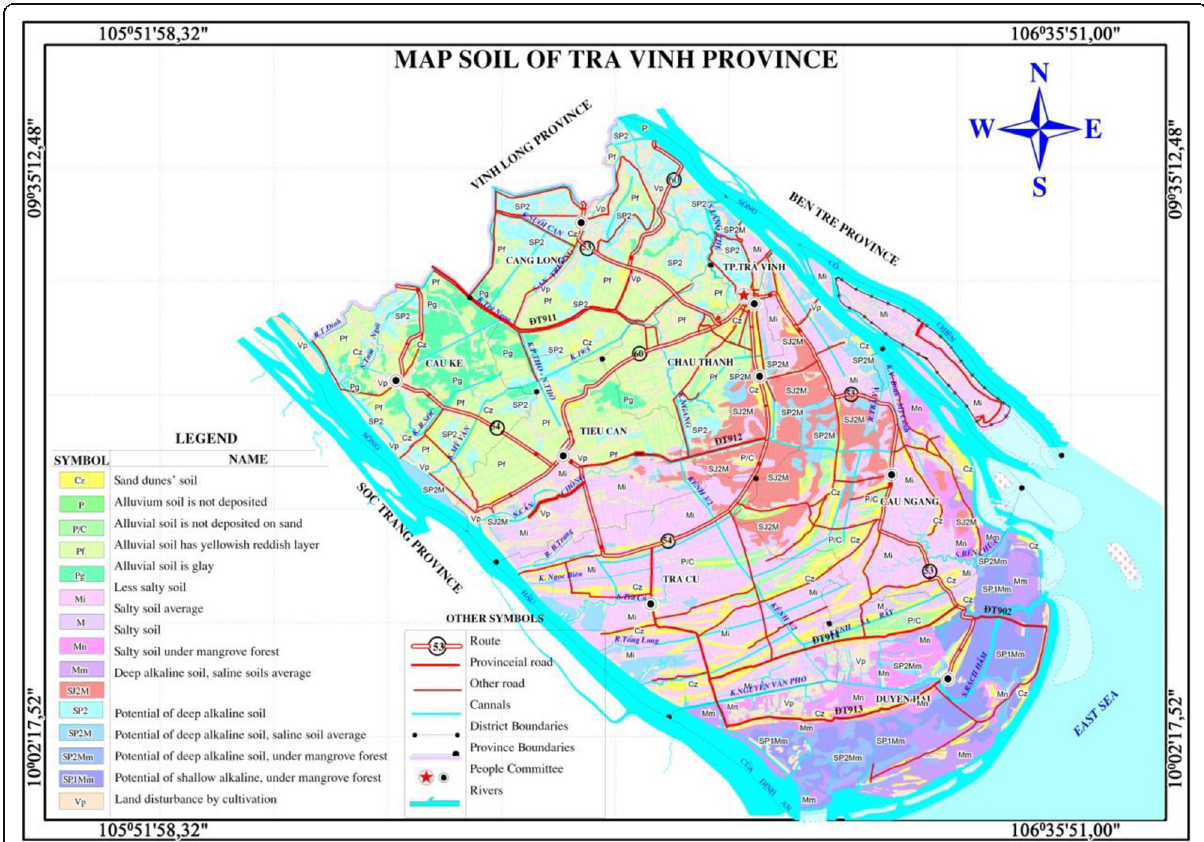
Fig. 2 The soil classification map of Tra Vinh Province (Source: Vietnam Department of Surveying and Mapping,